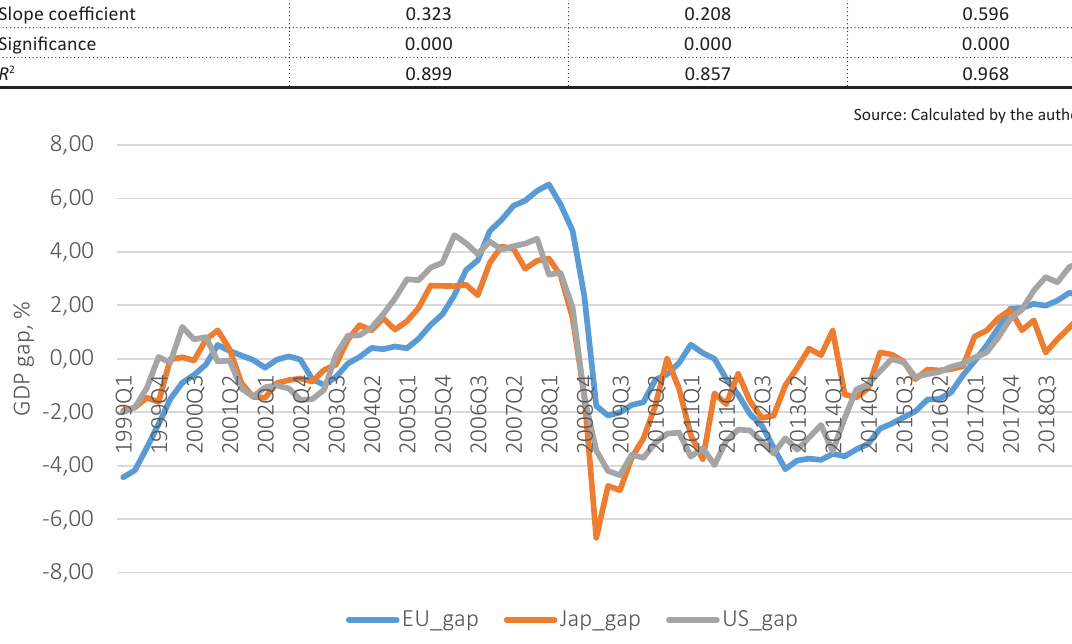
Figure 2. Dynamics of GDP gaps of the considered countries